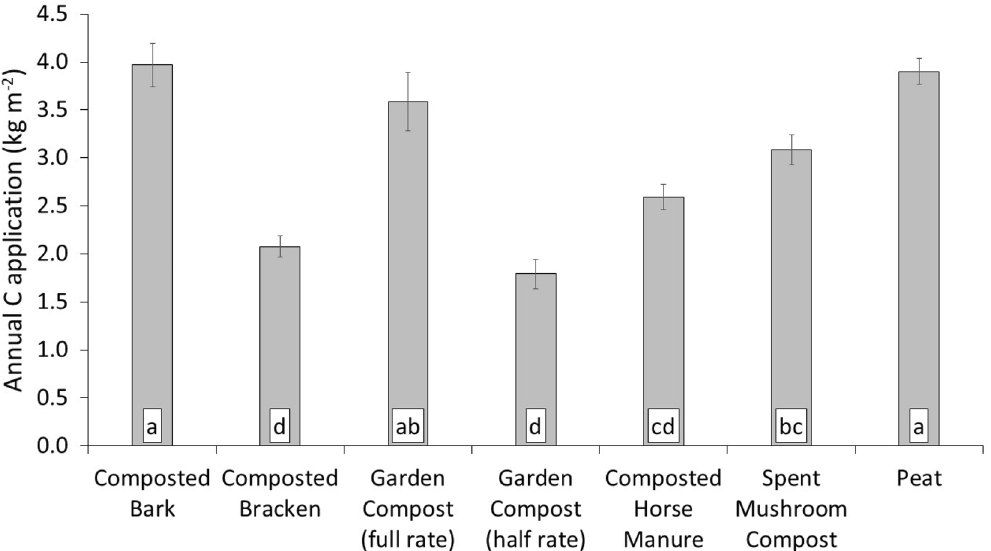
Figure 2. Annual C application of horticultural amendments. Mean of seven annual batches of amendments (n = 7). Error bars for standard error. Treatments that share a lower-case letter label have no significant difference according to one-way ANOVA and Tukeys post-hoc testing ( p >